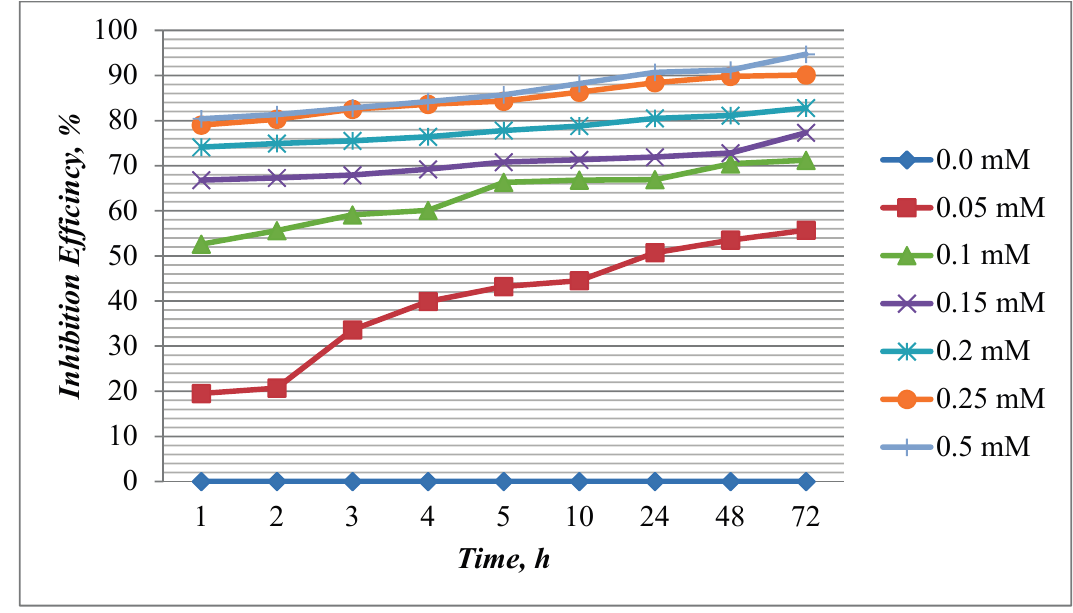
Figure 2. Influence of concentration of EFCI and time on inhibition efficiency of mild steel at 303 K.